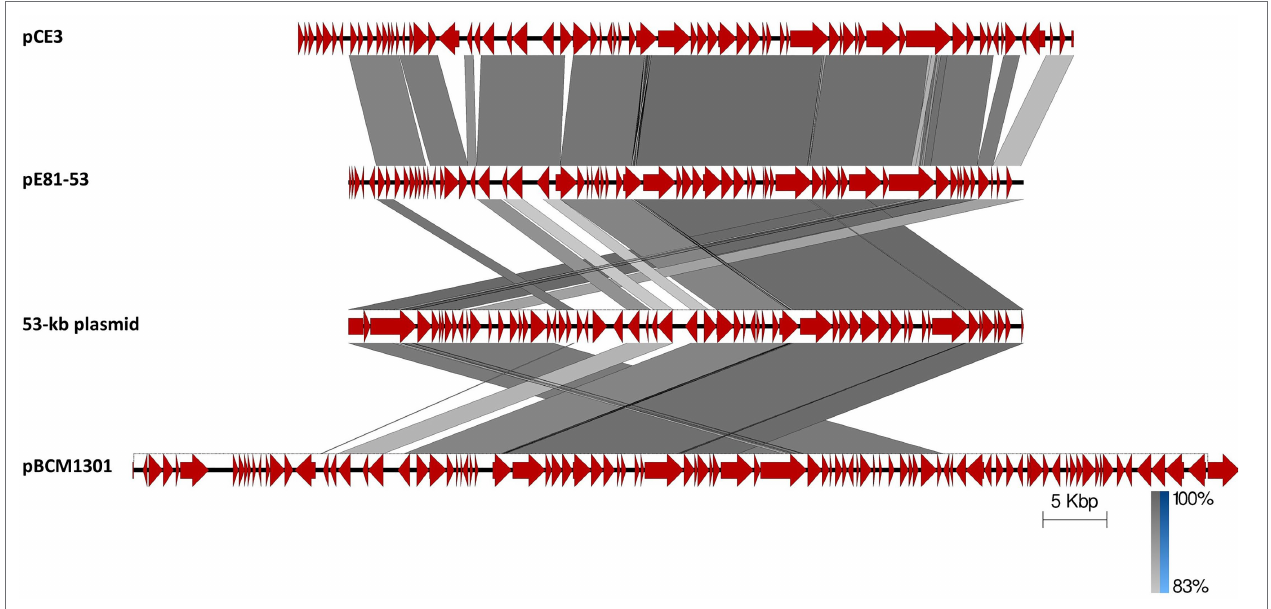
FIGURE 5 | Linear alignment of pCE3 from B. paranthracis strain BC307 (CP047088.1), pE81-53 and the 53-kb plasmid (Stevens et al., 2019) from B. cytotoxicus , and pBCM1301 from B. cereus strain M13 (CP016361.1). CDSs are represented by block arrows. Darkening gray shading reflects increasing nucleotide BLAST sequence identity. Scale and identity percentage are indicated in the lower right-hand